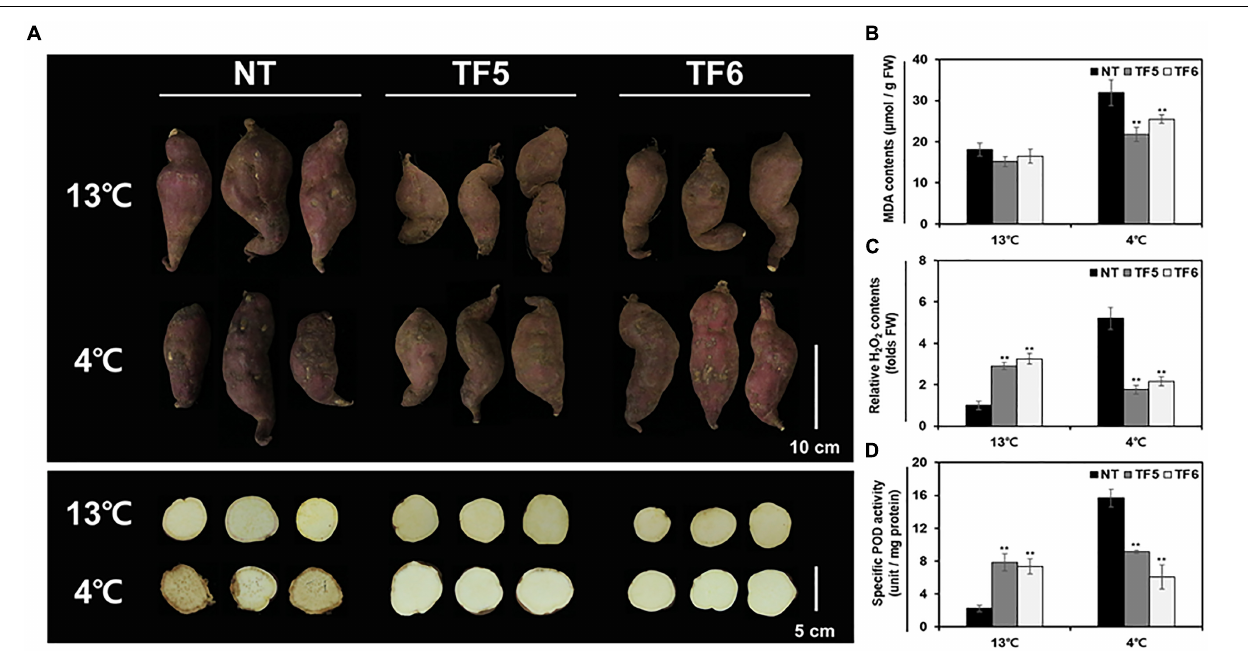
FIGURE 5 | Evaluation of the low-temperature storage ability of the tuberous roots of sweetpotato plants. (A) Phenotypes of tuberous roots stored at normal temperature (13 ◦ C) and low temperature (4 ◦ C). Whole tuberous roots (upper panel) and root sections (lower panel) were photographed. (B–D) Quantification of MDA level (B) , hydrogen peroxide (H 2 O 2 ) level (C) , and specific peroxidase (POD) activity (D) in tuberous roots after storage. Asterisks indicate significant differences between NT and TF plants (* p < 0.05, ** p < 0.01; one-way ANOVA, followed by Tukey’s HSD post hoc